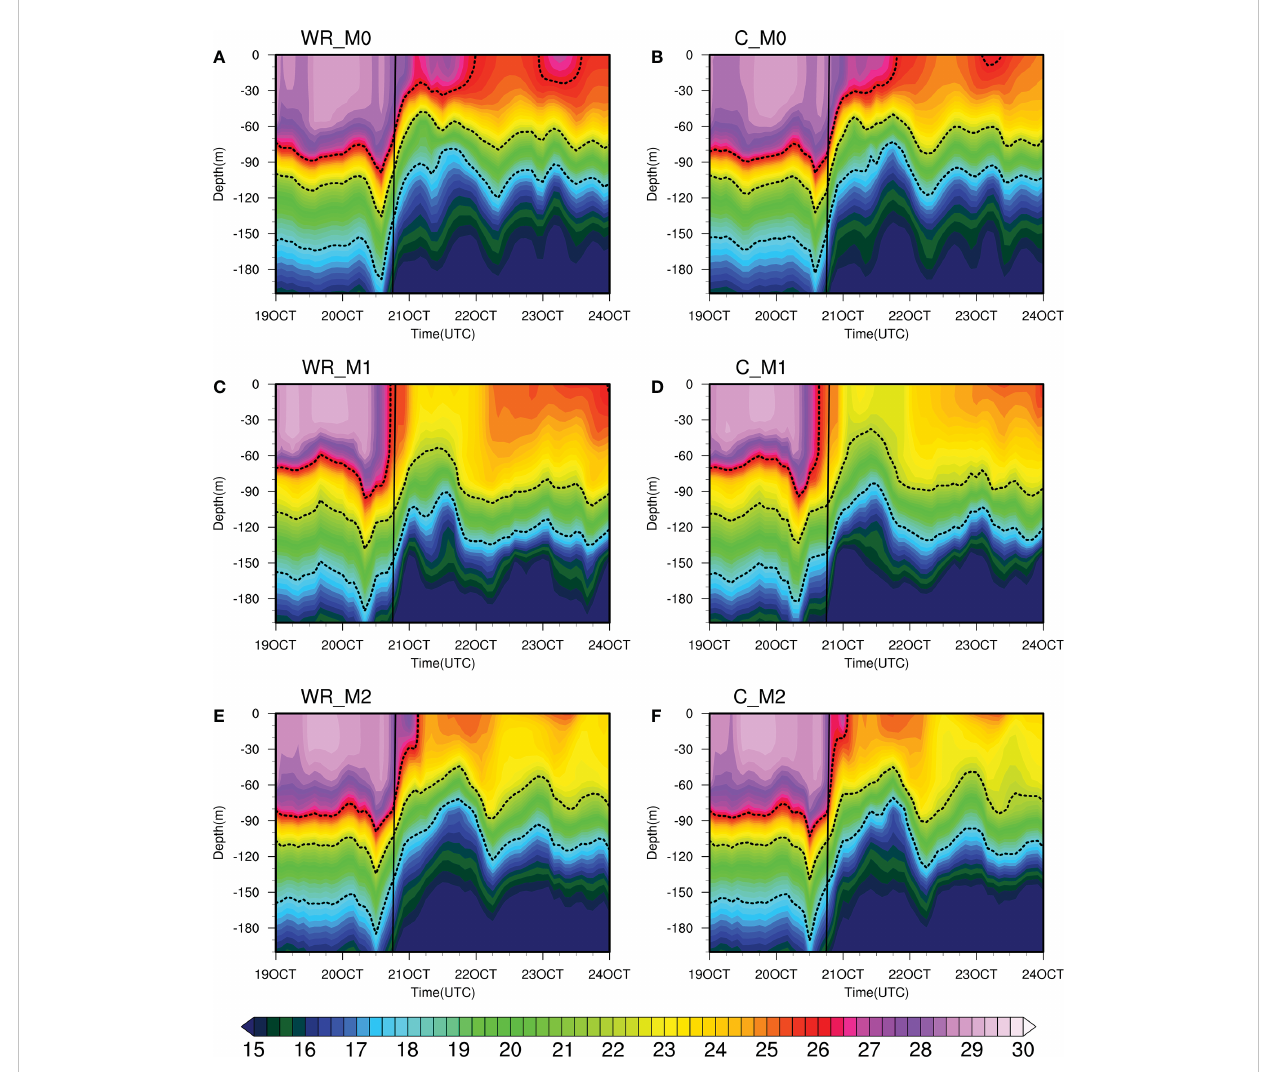
FIGURE 12 The simulated temperature variation azimuthally averaged at the RMW on the right side of TC center at 18 UTC 20 Oct versus time and depth in (A) WR_M0, (B) C_M0, (C) WR_M1, (D) C_M1, (E) WR_M2, and (F) C_M2. The vertical line indicates the time during Megi ’ s arriving. The three black isolines represent the 26, 22, and 18°C isothermal lines from top to bottom,